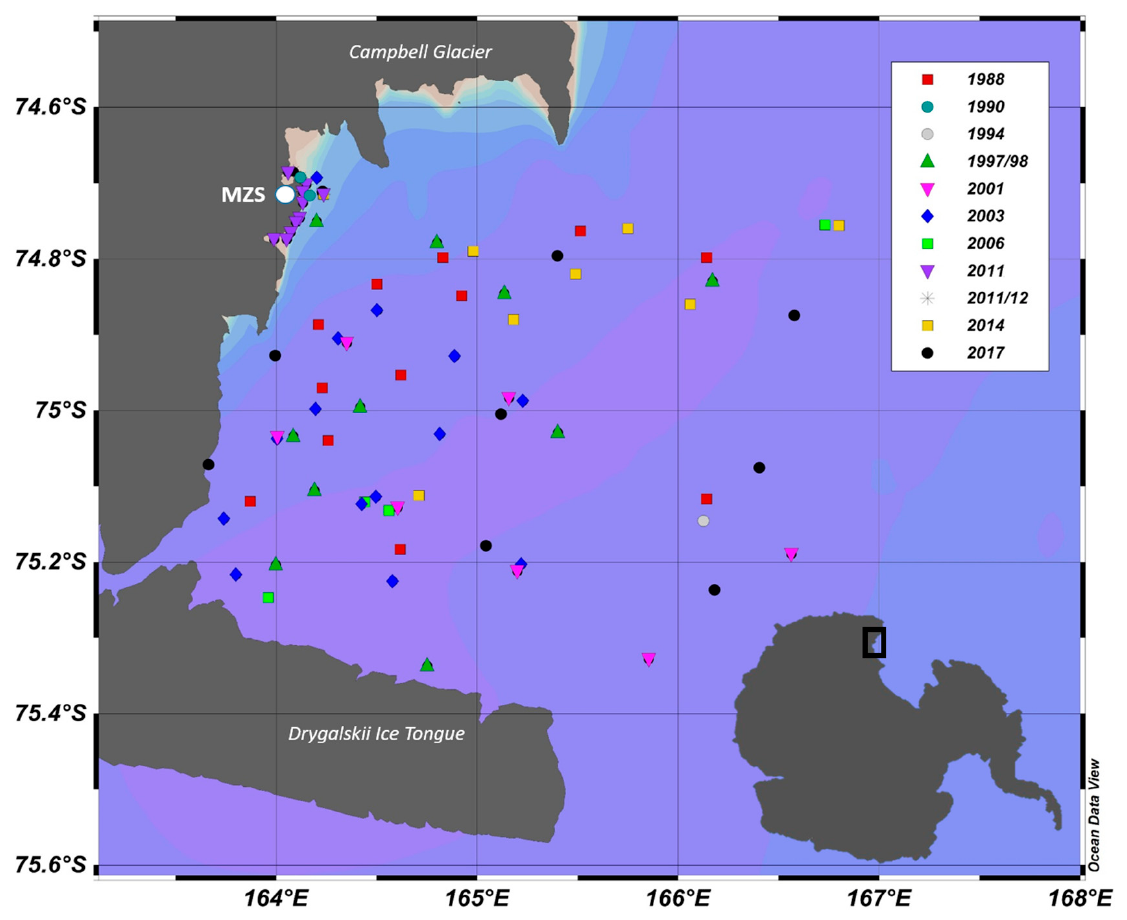
Figure 1. Survey stations in the Ross Sea polynya in the different years. Mario Zucchelli Station (MZS).